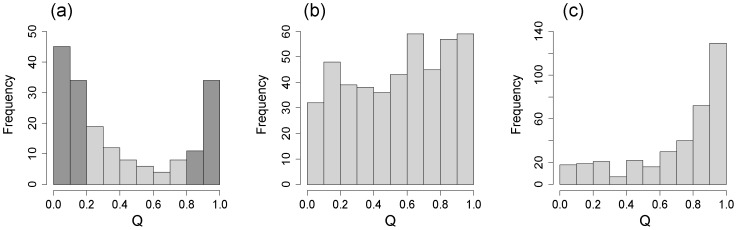
Frequency distributions of membership in the clusters defined by the reference population for C. japonica.(a) natural population (n = 181). Black bar represents the reference samples for STRUCTURE analysis. Q>0.8 indicates reference samples for Pacific Ocean side, while Q<0.2 those for Japan Sea side. (b) core collection (n = 456), (c) plus tree individuals in Kanto Breeding region (n = 367).